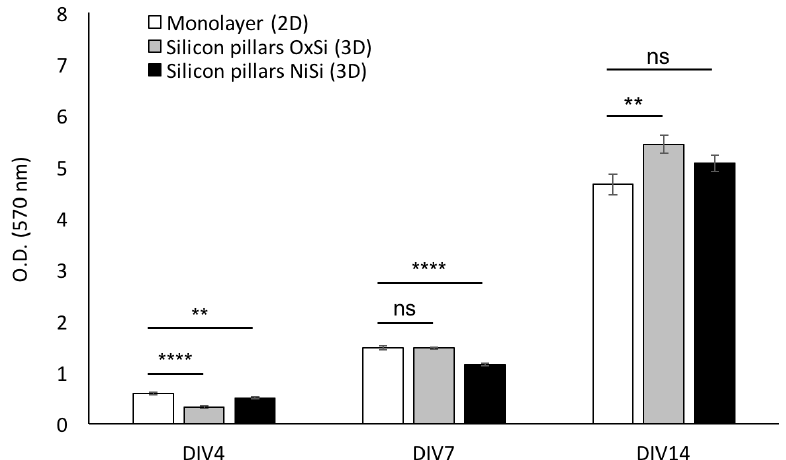
Figure 5. hCPs seeded on silicon slides maintain their proliferation capability. Cell growth analysis (MTT assays) performed on hCPs seeded on oxidized silicon (OxSi) or nitride silicon (NiSi) micropillar arrays. Standard 2D monolayer cultures were used as control. Cultures were assessed at different days in vitro (DIV) after seeding. p < 0.01 (**), p < 0.0001 (****), not significant (ns).